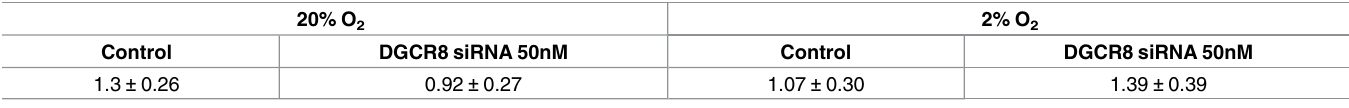
Table 2. HBEGF mRNA in HTR-8/SVneo cells with or without (Control) exposure to DGCR8 siRNA measuredby qPCR *